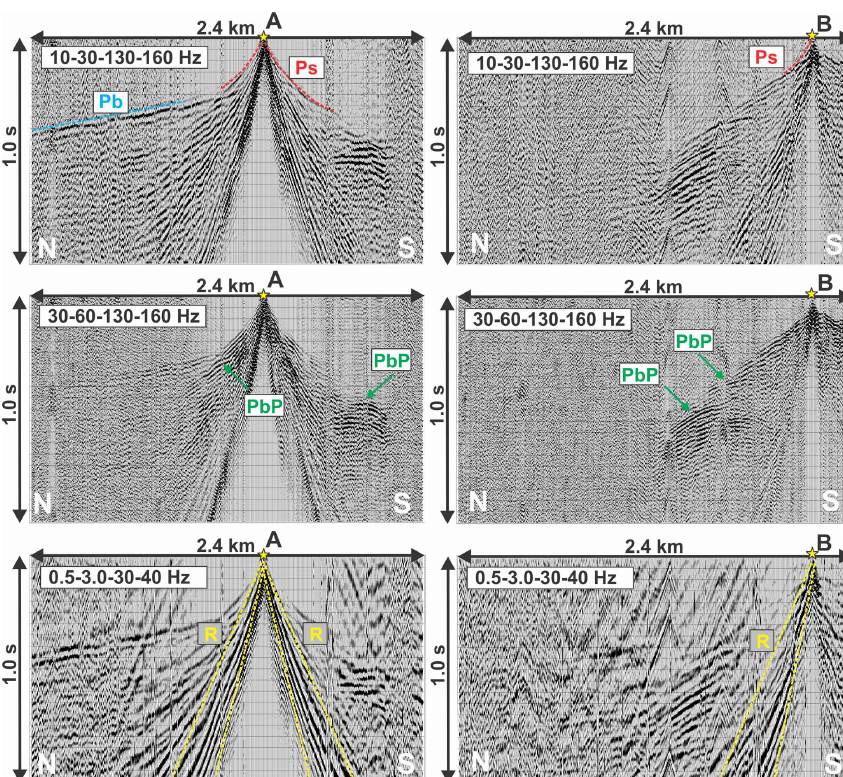
Figure 3. Seismic data examples: shot gathers A and B (location see Fig. 4) filtered in different frequency bands. Pb: refractions from the basement; Ps: refractions from the overburden (sediments); PbP: basement reflections; R: Rayleigh waves from the active source but not traffic-induced ground